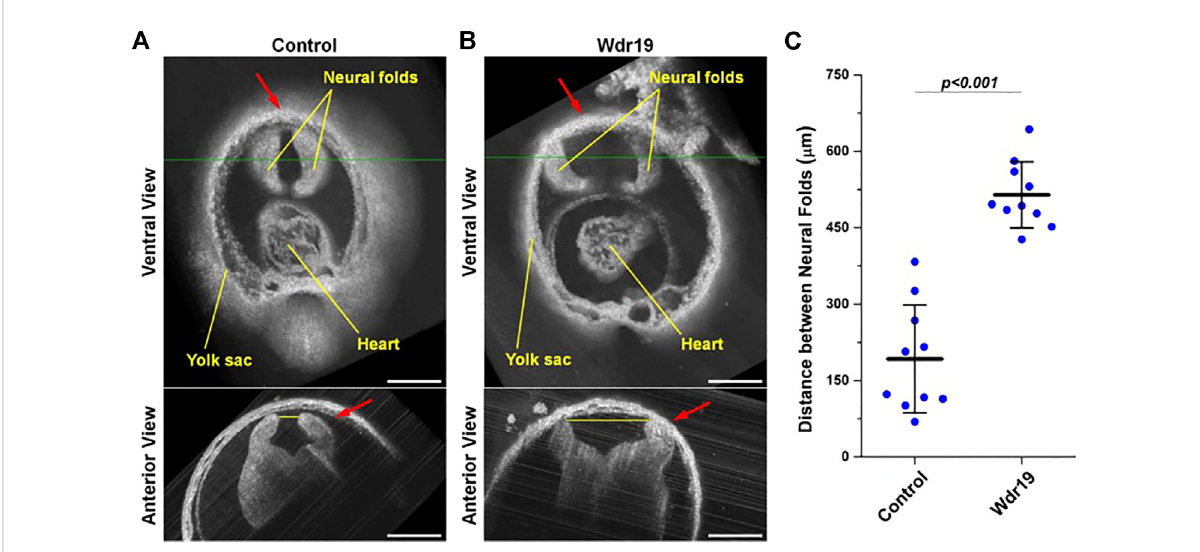
FIGURE 2 Live phenotyping in culture of the Wdr19 mutant mouse embryo. 3-D OCT images of the forebrain region from (A) control and (B) Wdr19mutantembryosatE8.5showanobviousdifferenceinneuraltubephenotype.Theredarrowsindicatetheforebrainregion.Thegreenlinesin the ventral views indicate the locations where the anterior views are taken. The yellow lines in the anterior views indicate the positions of distance measurement (scale bar: 300 µm). (C) Quanti fi cation of the distance between the neural folds at the forebrain region in control and Wdr19mutantembryos.Thedistancebetweentheneuralfoldsissigni fi cantlylargerinWdr19mutantembryoscomparedtocontrols( p < 0.001,two- sample t test). Data are presented as mean ± standard deviation. Reproduced from (Wang et al., 2017).